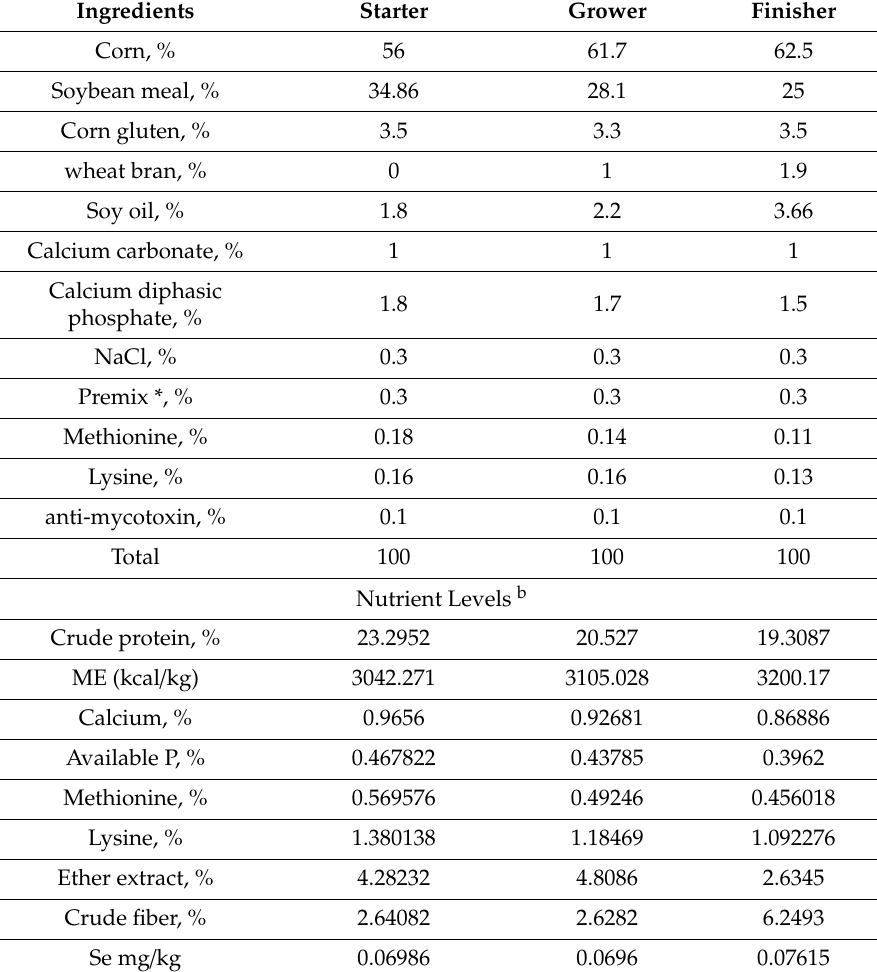
Table 1. The ingredients and nutrient levels of the basal diet (on dry matter